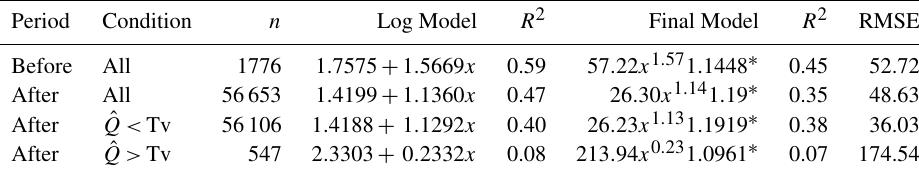
∗ Represents use of the Duan (1983) correction factor.